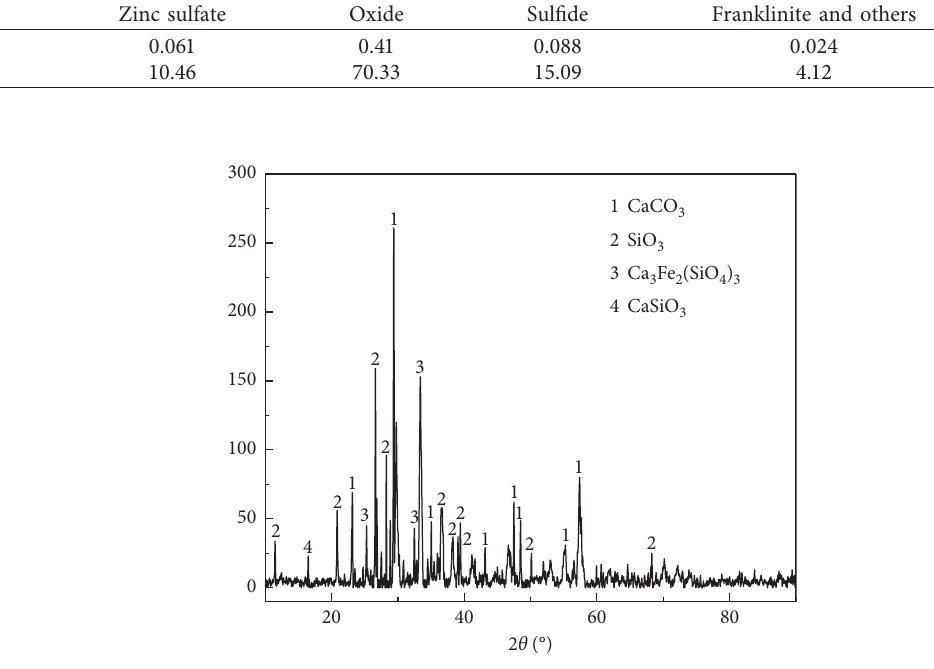
Figure 1: X-ray analysis results of the raw